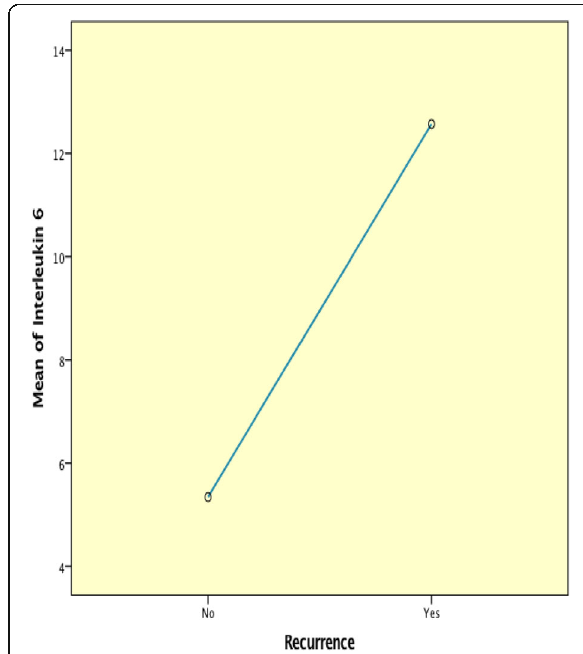
Fig. 3 Means plot between IL-6 levels against recurrence. IL-6 was significantly higher in patients with recurrence (12.5 ± 2.66) pg/ml than in patients without recurrence (5.34 ± 4.11) pg/ml ( P <